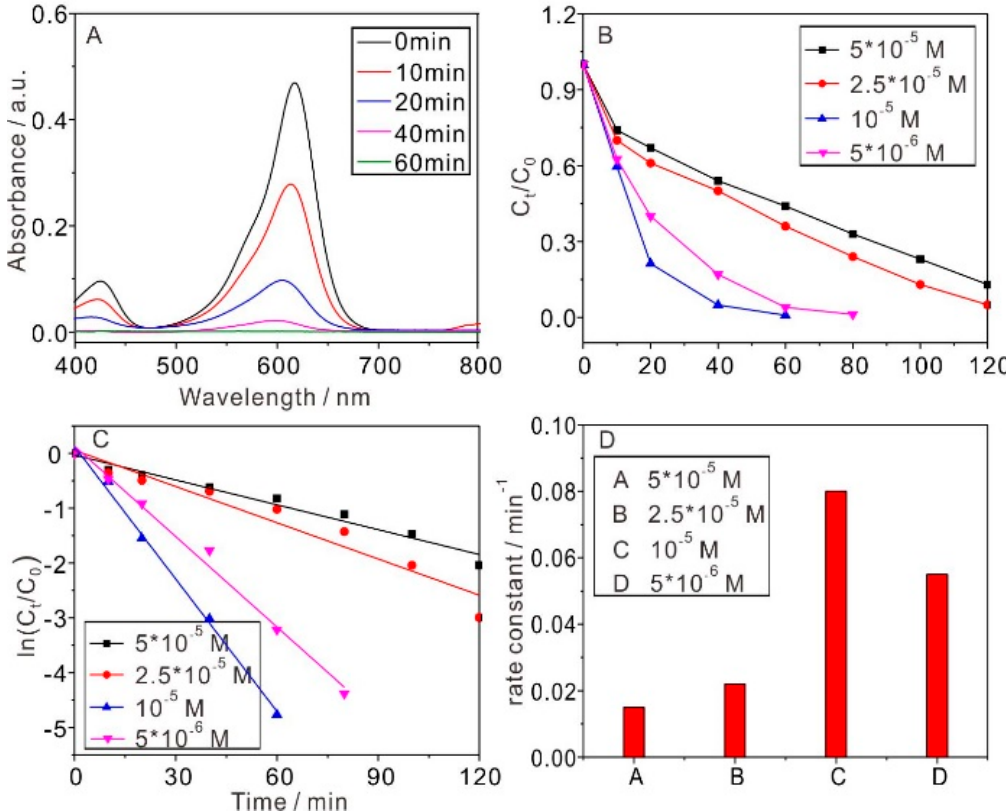
Figure 4. ( A ) Time-course UV-vis absorbance spectra of MG (10 − 5 M) photocatalyzed by 0.6 g/L TiO 2 under UV light; ( B – D ) The calculated time-dependent ratios of C t / C 0 , first-order degradation rates, and reaction rate constants for different concentration of MG photocatalyzed by 0.6 g/L TiO 2 under UV light.